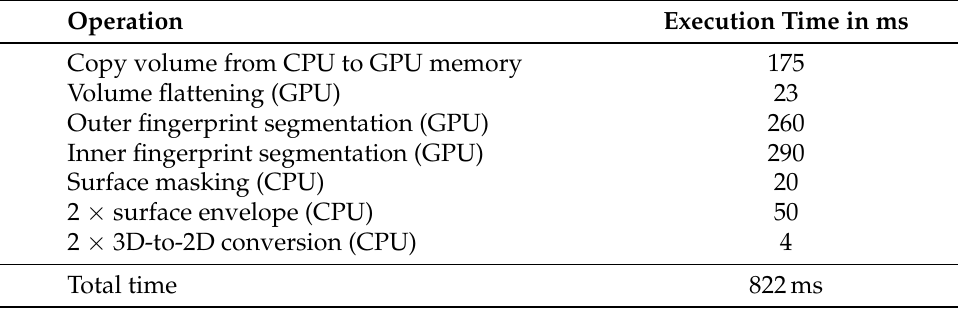
Table 1. Computation times on 3rd gen. AMD Ryzen and Nvidia RTX